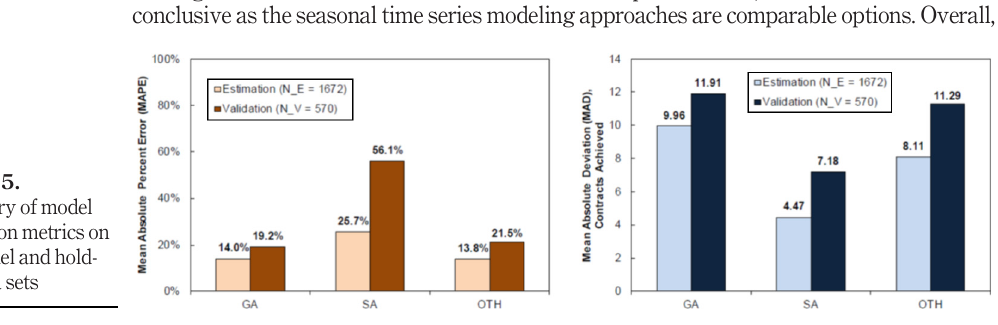
Figure 4. Contracts achieved and model forecasts for the three contract types at top-most echelon results for each of the output measures. The legend in each of the sub- fi gures provide a speci fi cation of the univariate model fi t; development details are not provided here. For each of the GA and OTH models, it is quite clear the multivariate models are the preferred approach, realizing of course that these models do already contain a single autoregressive term. For the more seasonal SA response model, the results were not so conclusive as the seasonal time series modeling approaches are comparable options. Overall,